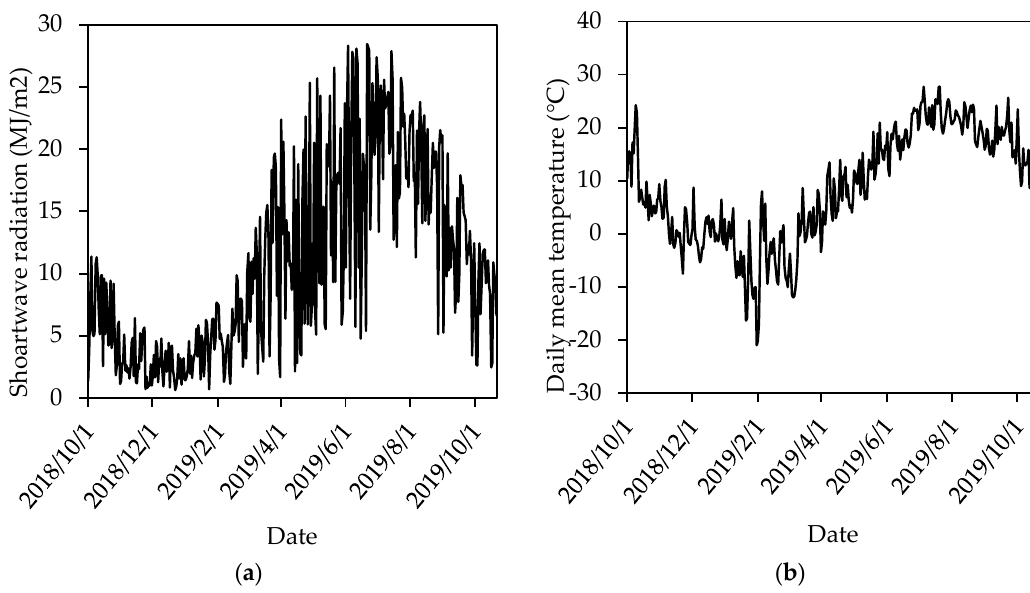
Figure 5. Daily shortwave solar radiation ( a ) and mean air temperature ( b ) for the study site between 1 October 2018 and 1 October